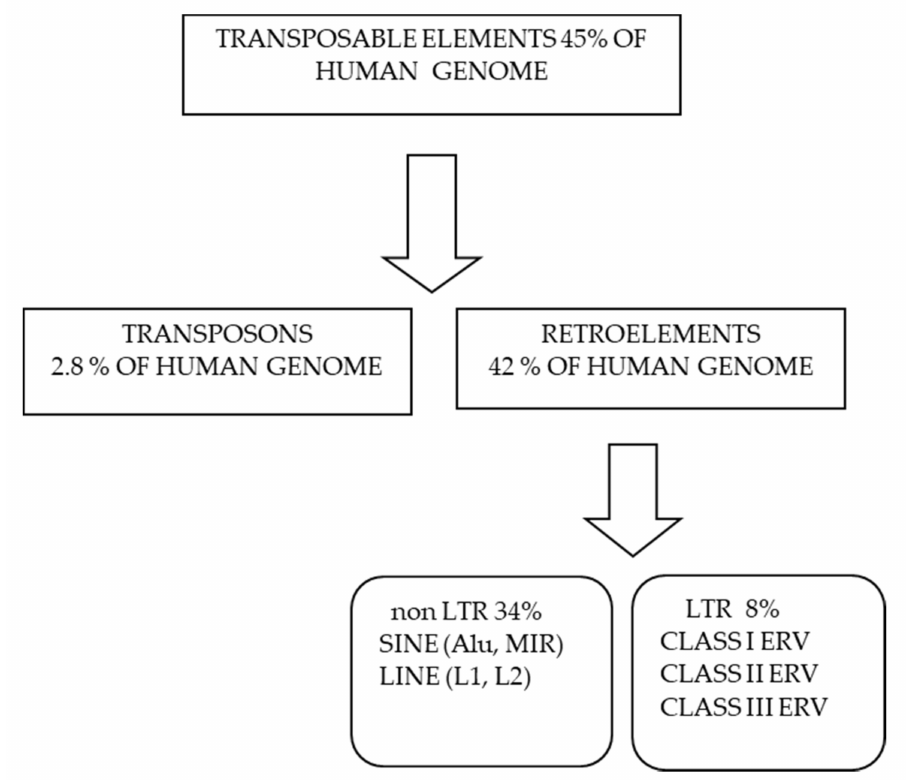
Figure 1. Classification of transposable elements and their relative abundance in human